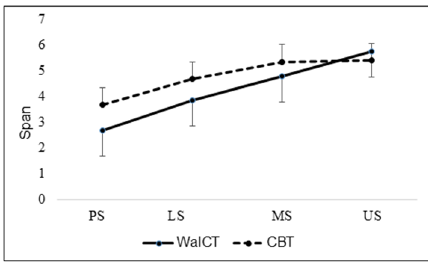
Figure 3. Visuospatial working memory with respect to age in the entire study group.